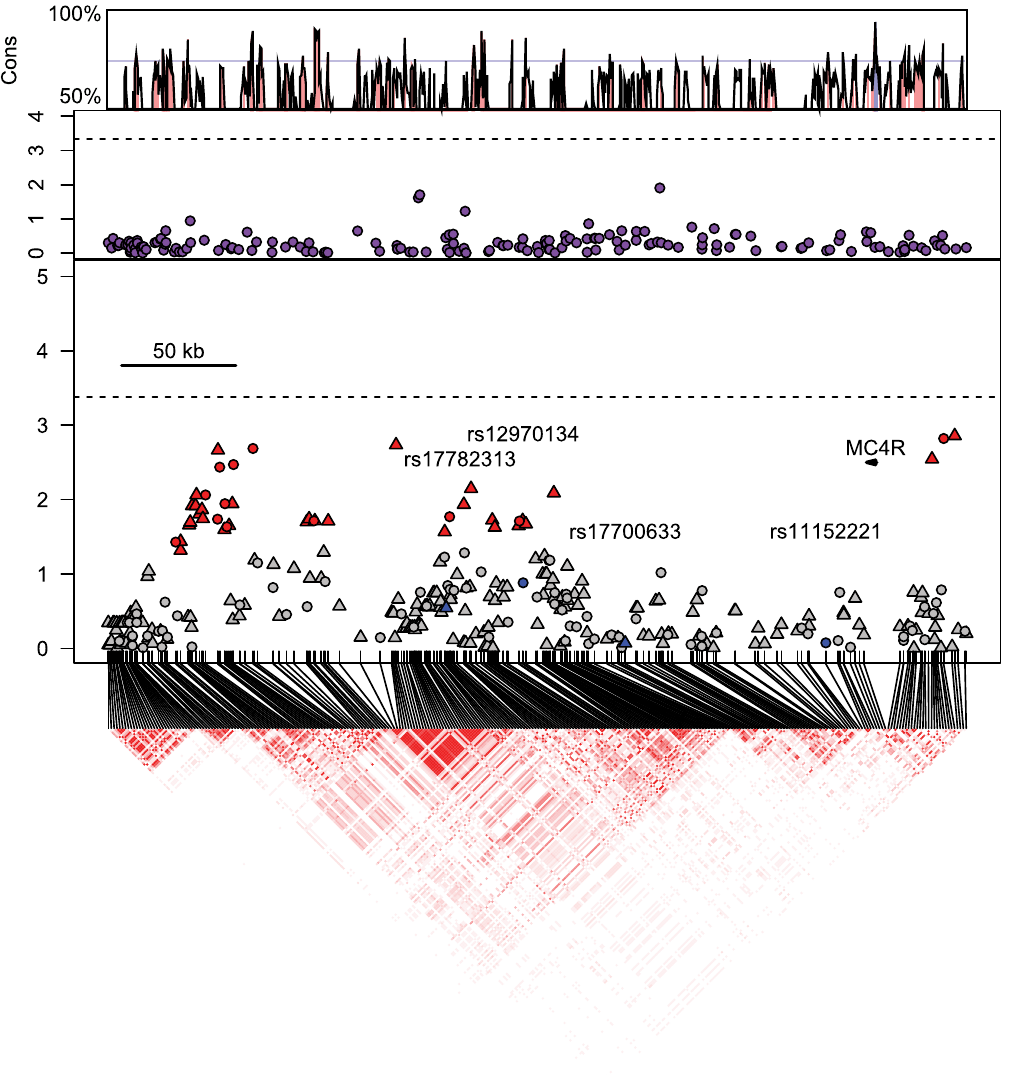
Figure 3. Association between BMI and genotyped and imputed SNPs in black Health ABC participants. SNP genotypes from genome- wide Illumina array. Circles mark directly genotyped SNPs and triangles mark imputed SNPs. Gray points indicate association P -value . 0.05. Red points indicate significant ( P -value # 0.05) associations with BMI. Anchor SNPs colored in blue. Purple circles mark SNP association with MC4R expression in HapMap YRI lymphoblastoid cell lines. In the panels showing trait association and eQTL P -values, the dashed line indicates cut-off value for Bonferroni-corrected P -value # 0.05. LD heatmap indicates higher r 2 measures with darker red colors. Nucleotide conservation between the human and mouse is indicated on the top panel of the figure and was obtained using the VISTA